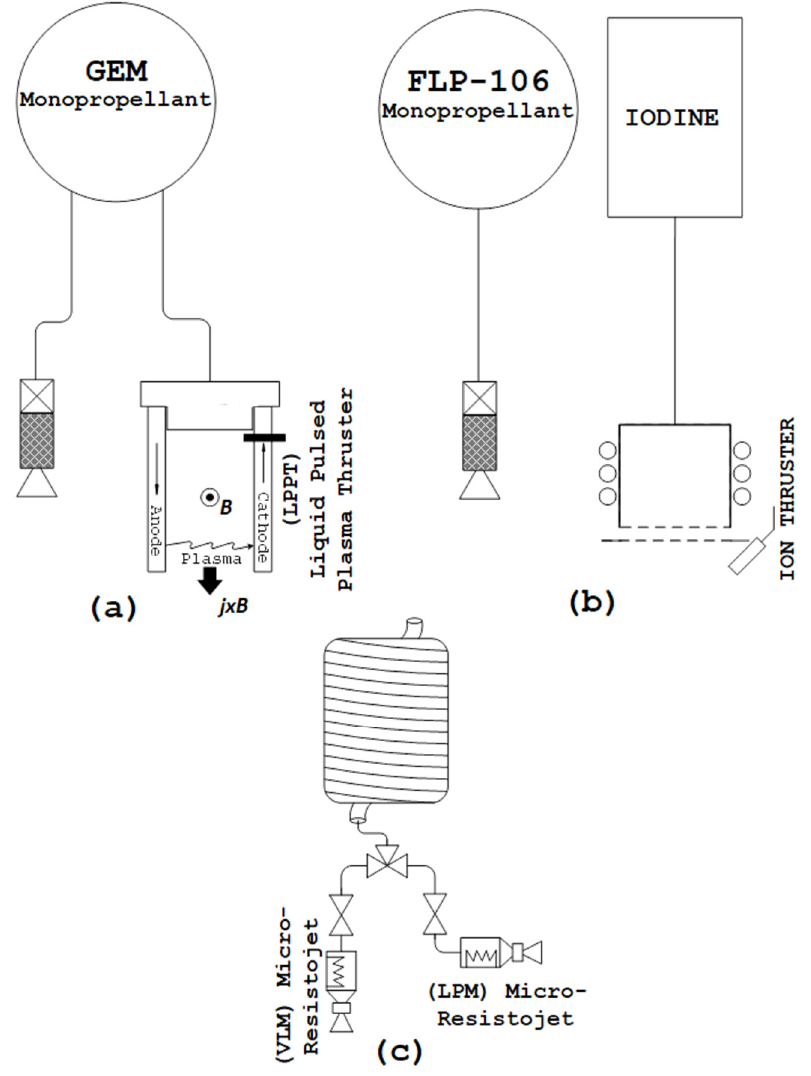
Figure 2. Combined Chemical-Electric Propulsion (CCEP): ( a ) a multi-mode configuration of a chemical catalytically decomposed monopropellant system alongside an electric Liquid Pulsed Plasma Thruster (LPPT) both sharing the same Green Electric Monopropellant (GEM) developed by Digital Solid-State Propulsion (DSSP) Aerospace; ( b ) is a CCEP dual propulsion system, the chemical system is burning FLP-106 while the electric propulsion system is separately fueled by iodine. ( c ) A pico-satellite multi-mode electrothermal propulsion system consisting of two micro-resistojets, Vaporizing Liquid Micro-resistojet (VLM) and Low Pressure Micro-resistojet (LPM), both fueled by liquid water as green monopropellant that is provided by a shared storage tank of rolled small diameter tube relying on the capillary action phenomenon